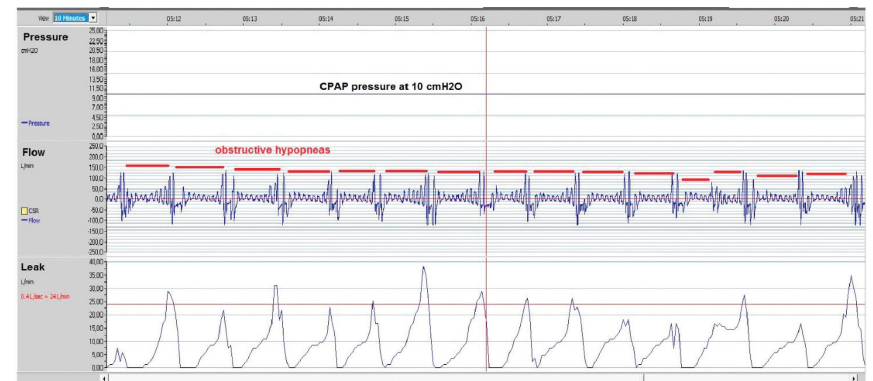
Figure 6: A 10-minute screenshot from the ResScan program for CPAP follow up. In the lower panel, we see an intermittent air leak that caused instantaneous pressure drop in the upper airways and led to obstructive